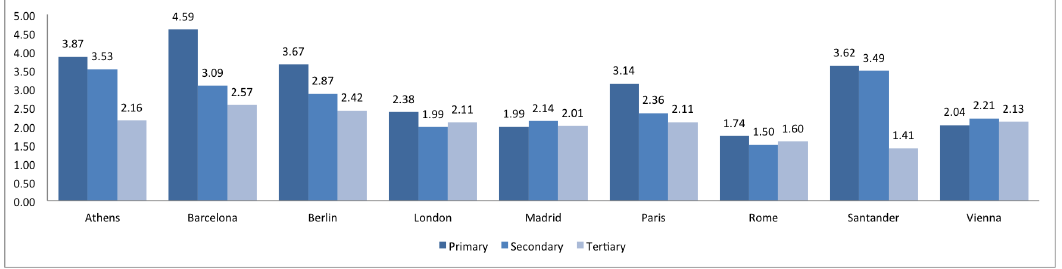
Figure 24. Consistency study of highway in Europe. Standard deviation of the tag